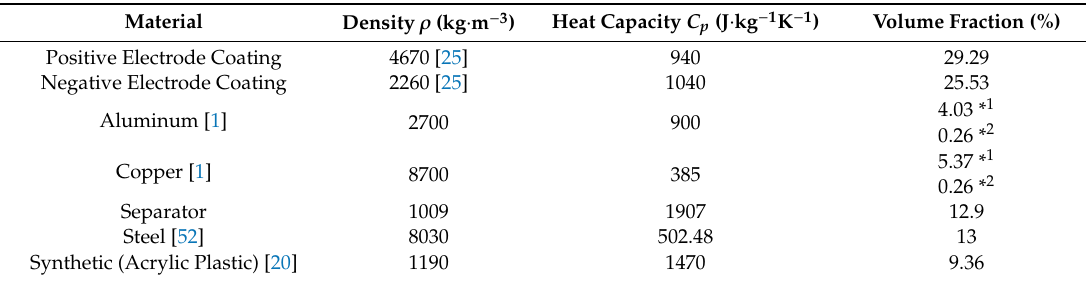
Table 4. The parameter list of volumetric thermo-physical properties of the battery cell for the reference temperature 25 ◦ C.